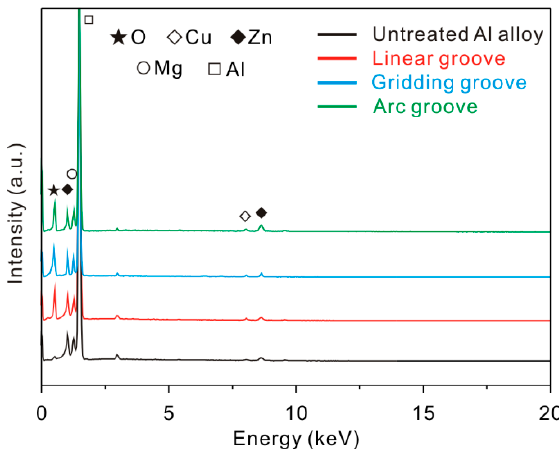
Figure 4. Electron dispersive spectroscopy (EDS) spectra of the Al alloy micro-scale structure surfaces. Table 3. Composition content of the micro-scale structure surfaces.